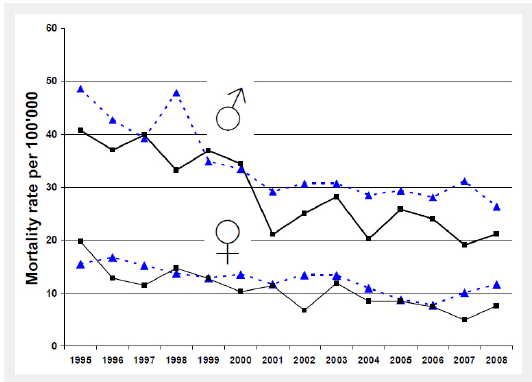
Age-standardised mortality rate (per 100'000 inhabitants) for myocardial infarction in the Cantons of Lucerne (triangles; dashed line) and Graubünden (squares; solid lines), 1995–2008, for men and women. Age standard: WHO world population. Mortality data: from death statistics of the Swiss Federal Statistical Office (FSO). Standardisation and graph: by Verena Jürgens, Swiss TPH